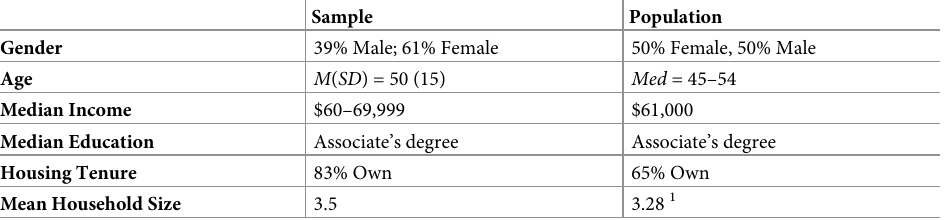
Table 1. Survey sample characteristics compared to Riverside County population; source: US census 2017 Ameri- can Community Survey